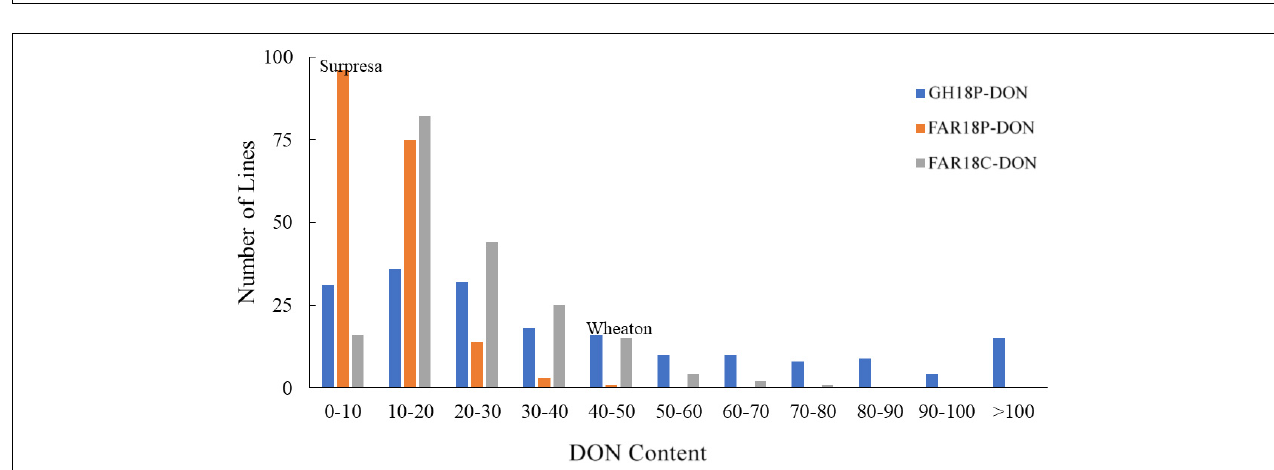
FIGURE 2 | Frequency distributions of FHB severity in the Wheaton/Surpresa RILs across field experiments. FAR16P, FAR17P, and FAR18P indicate the field experiments performed in 2016, 2017, and 2018, respectively, at the Fargo location with the point-inoculation method, while FAR18C was used to represent the corn-spawn inoculated experiment conducted at the Fargo location in 2018. FHB severity (proportion of symptomatic spikelets in a spike) was assessed and calculated as described by Stack and McMullen (1998).